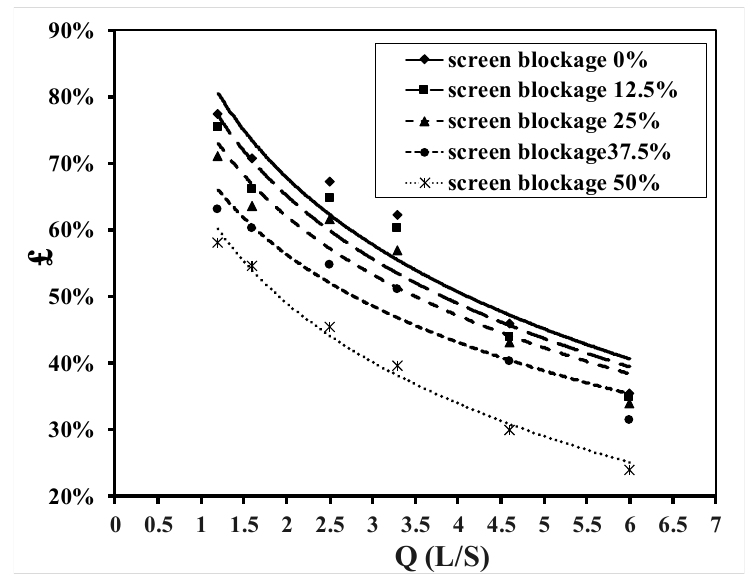
Figure 23. Relationship between £ and Q for different surface blockages without pipe blockage.